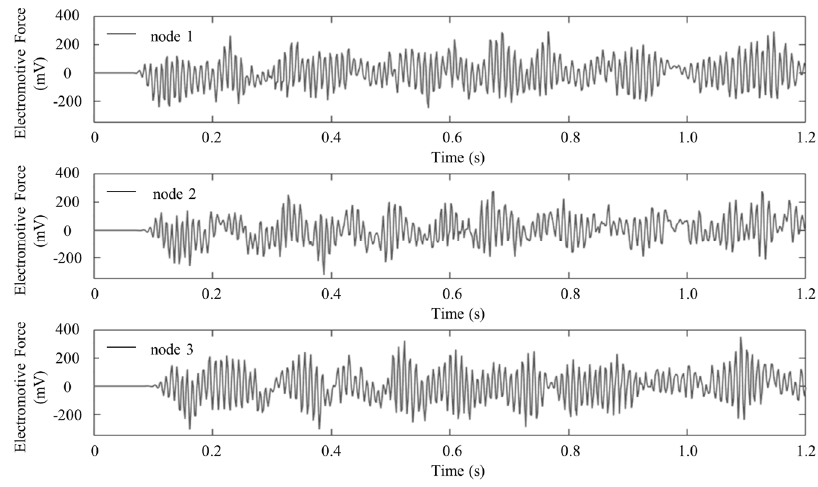
Figure 14. The coil electromotive force at the nodes.